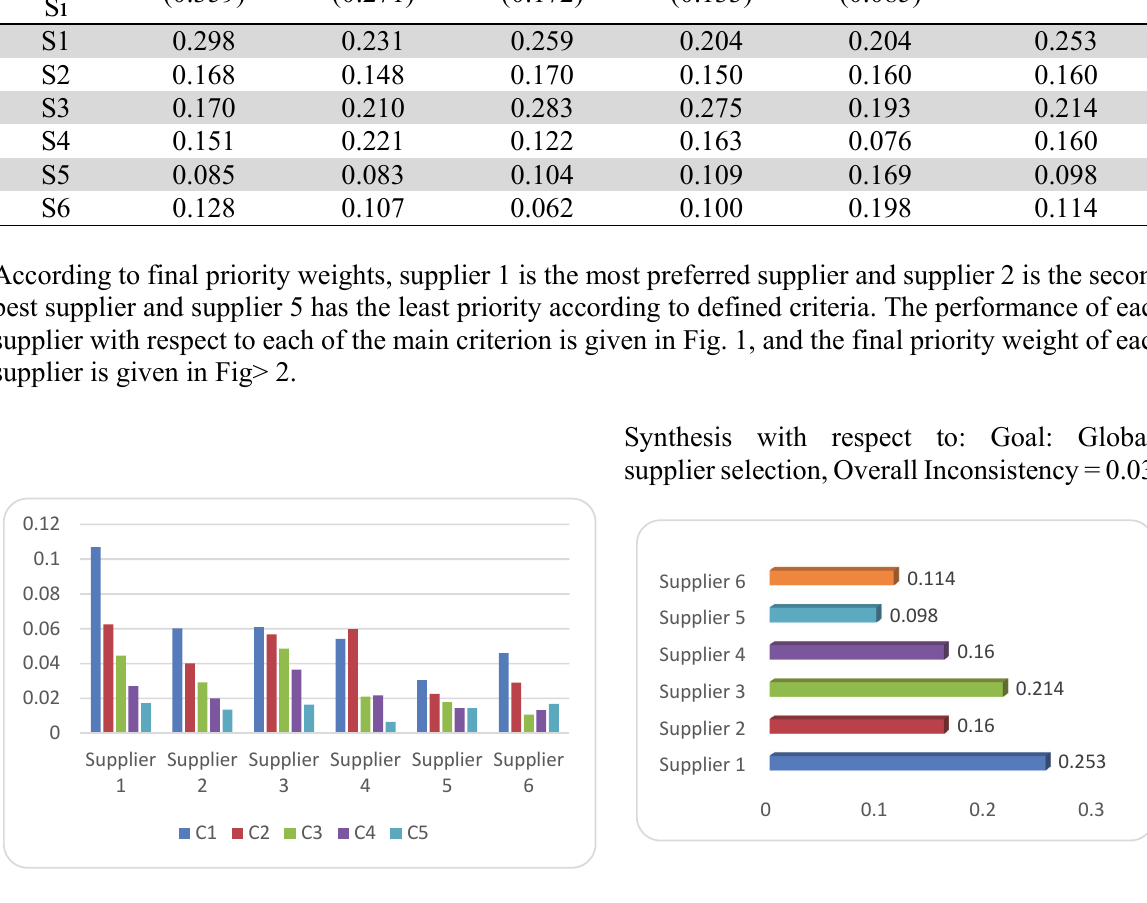
Fig. 1. Supplier performance with respect to the main criteria Fig. 2. Final priority weight of each